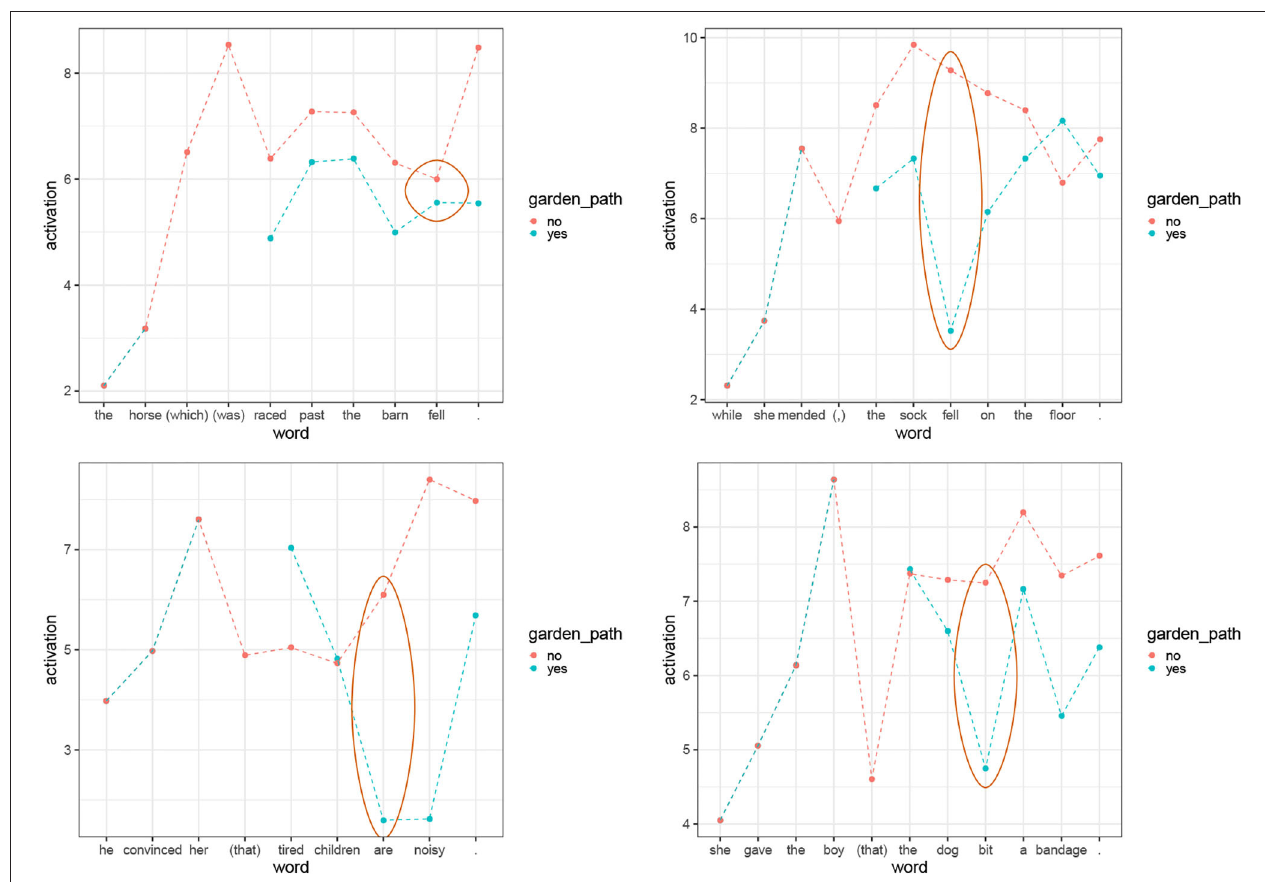
FIGURE 2 | Activations per word for sentence pairs (18)–(21). The yellow bars represent the activations in the sentences that disambiguate early. The blue bars are the activations of the garden-path sentences. The ellipses highlight the activations on the words that trigger the garden-path